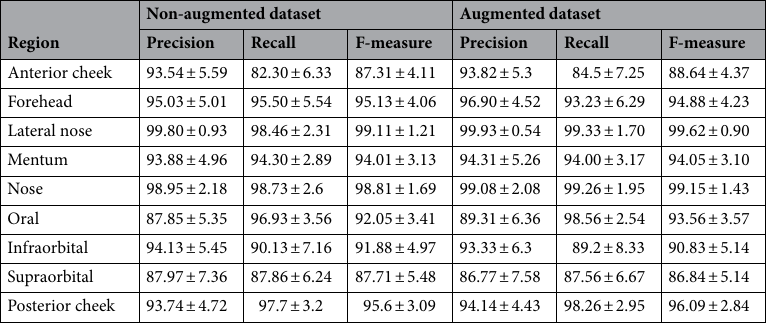
those of NasNet-Mobile, which were 88.72%, 87.22%, and 87.23%, respectively. The highest fold scores were those of the VGG-19 fold, which were 97.85%, 97.77%, and 97.79%, respectively (Table 3 and Fig. 5). The precision score for region classification was lowest in the orbit-upper region at 86.77 ± 7.58%, followed by that of the oral region, which was 89.31 ± 6.36%. The recall score was lowest in the anterior cheek at 84.5 ± 7.25%. The F-measure scores were the lowest in the anterior cheek and the orbit-upper regions at 88.64 ± 4.37% and 86.84 ± 5.14%, respectively. The lateral nose region exhibited the highest precision, recall, and F-measure scores, which were 99.93 ± 0.54%, 99.33 ± 1.7%, and 99.62 ± 0.9%, respectively (Table 4 and Fig. 6).